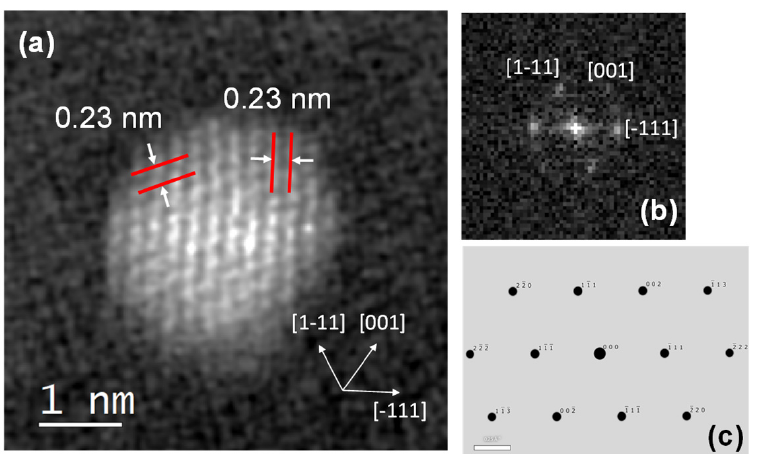
Figure 8. HAADF-STEM image of Pt nanoparticle oriented in [110] zone in sample FE-1 ( a ); FFT of HAADF-STEM image of Pt nanoparticle in [110] zone axis ( b ); simulated SAED pattern of cubic Pt in [110] zone ( c ).